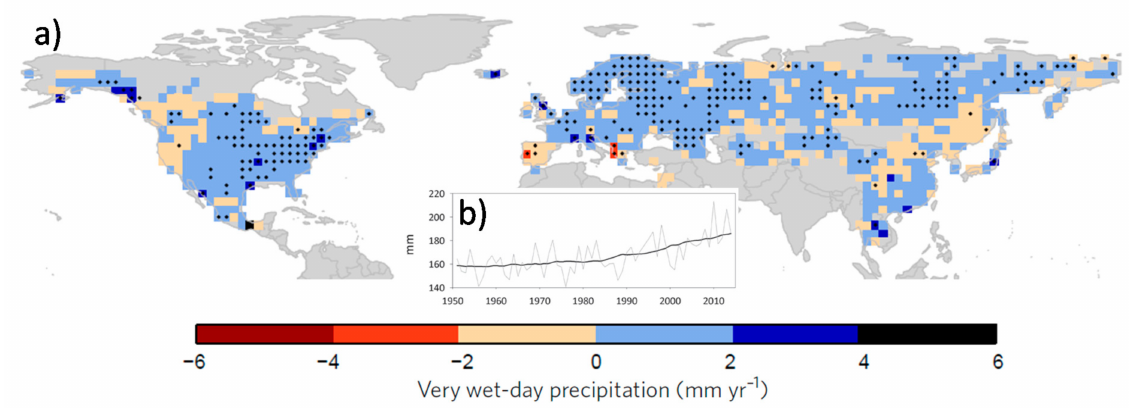
Figure 1. ( a ) Very wet-day precipitation (during days exceeding the 95th percentile) averaged over land areas from 20 ◦ N to 50 ◦ N for 1951–2013; ( b ) Related time series (grey) and trend